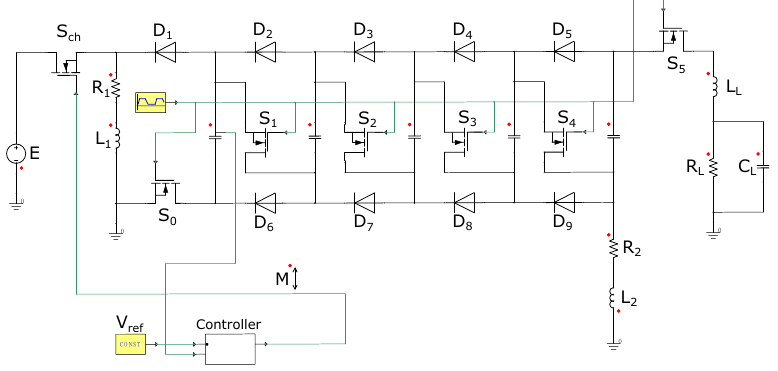
Figure 7. ANSYS-Simplorer simulation model of the